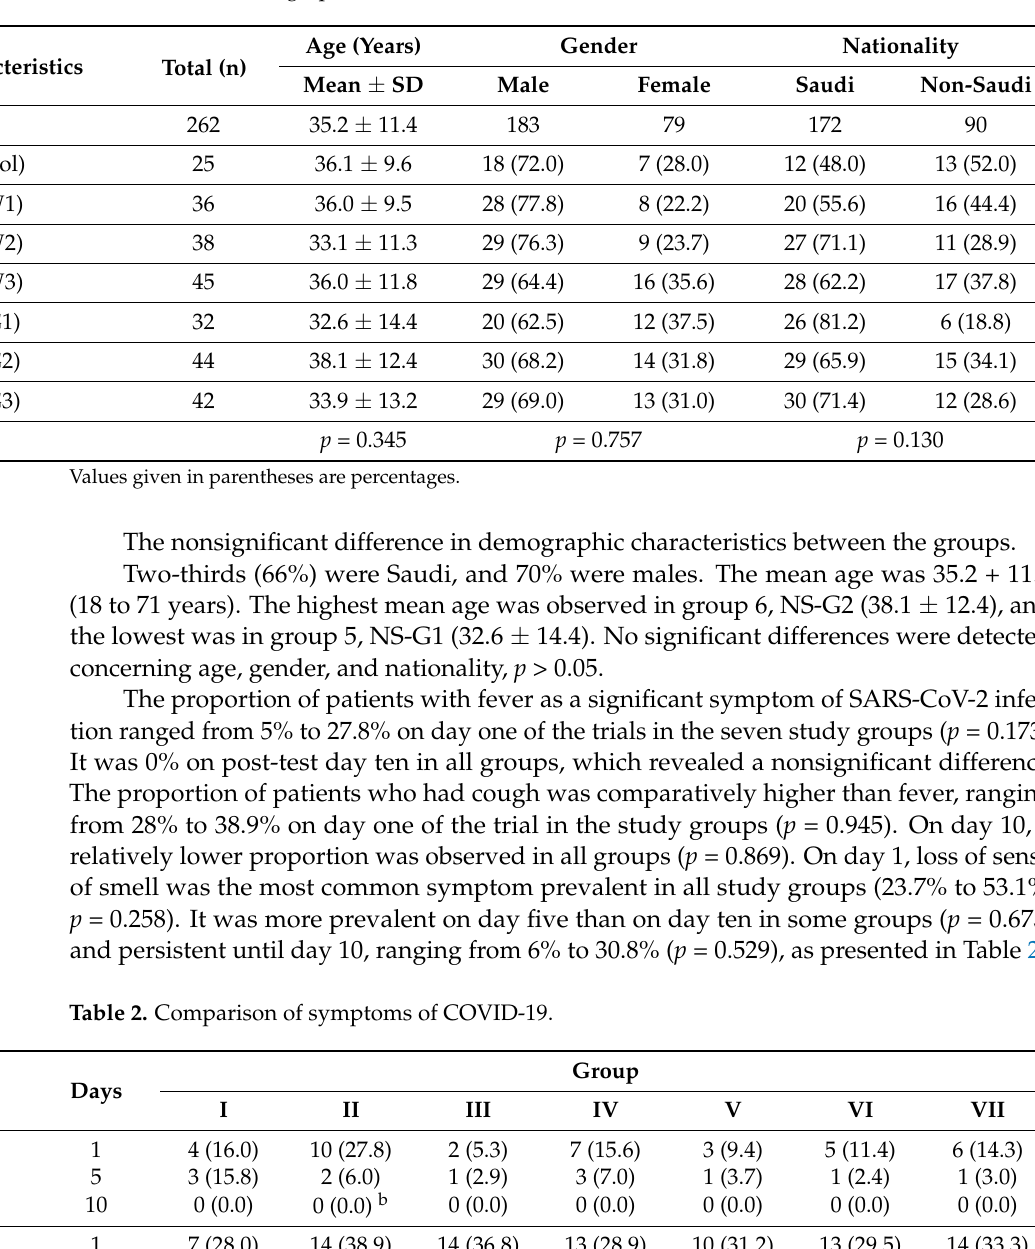
Table 1. Patient demographic characteristics.